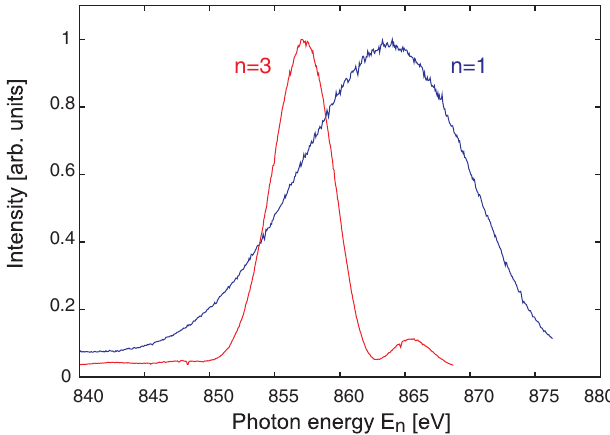
FIG. 7. (Color) On-axis high-resolution energy spectra of the fundamental ( n (cid:1) 1 ) and the more narrow third harmonic ( n (cid:1) 3 ) undulator radiation for an electron energy of 705 and 405 MeV, respectively.